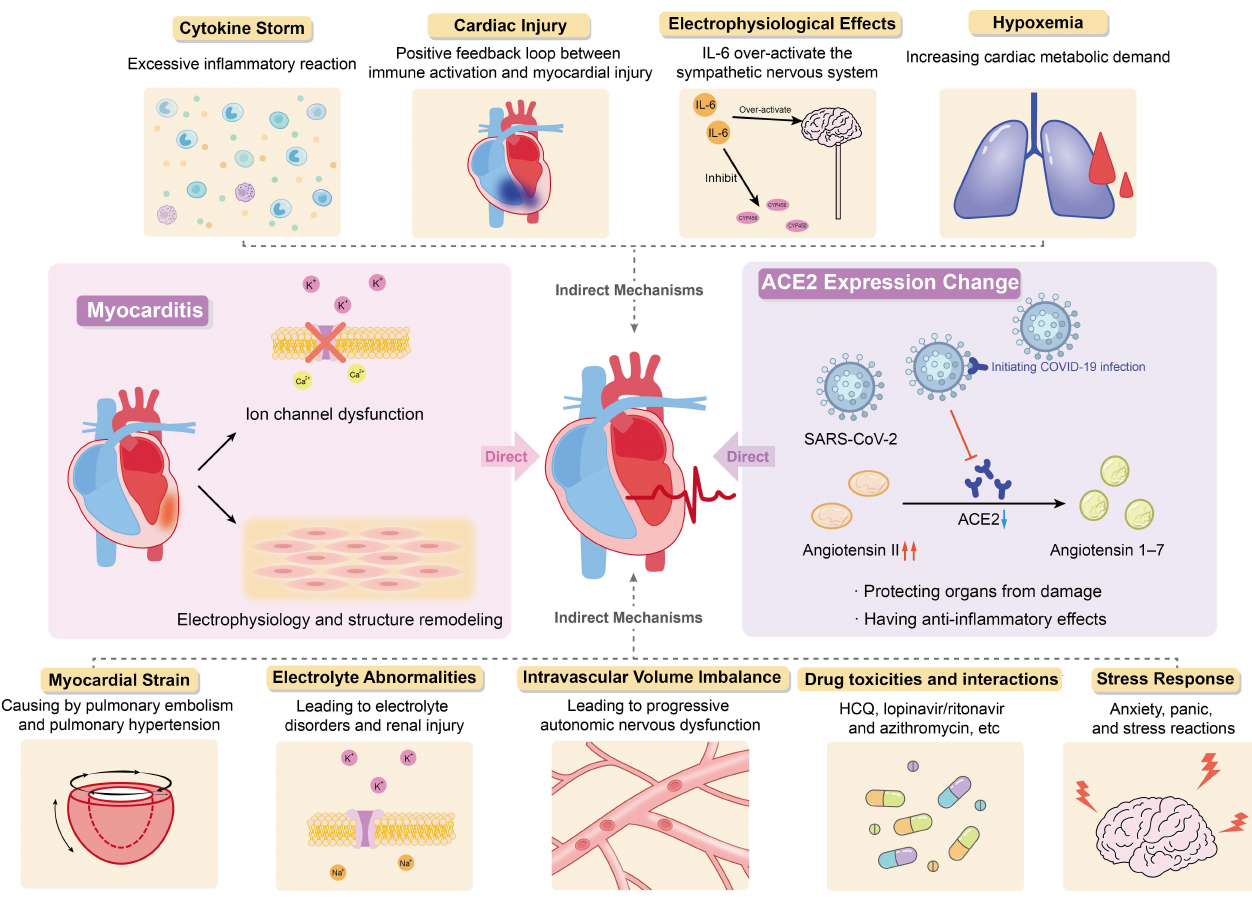
Figure 1. Potential Mechanism of COVID-19 Complicated with